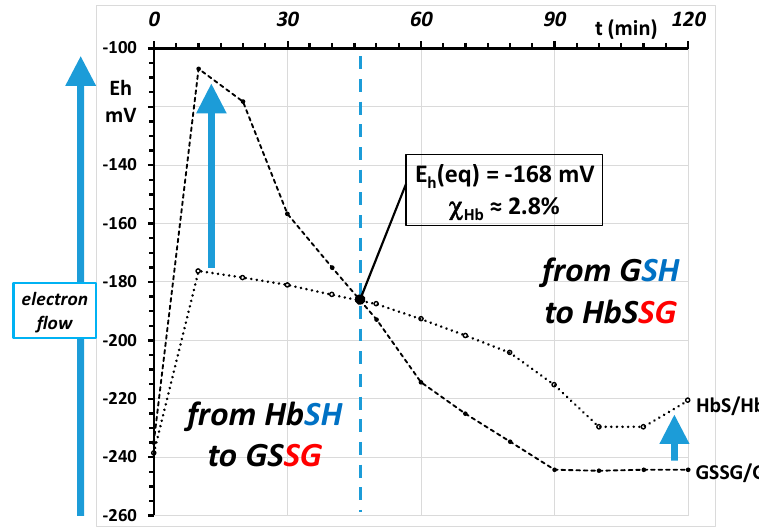
Figure 4. Electrochemical potential (E h ) of the GSSG/GSH and HbS/HbSH redox pairs during the oxidative burst and recovery experiment. The E h values are calculated on the basis of the measured concentrations of GSH, GSSG, HbSSG and of the values of E 0 for glutathione (264 mV, literature data) and for hemoglobin ( − 121 mV, calculated above).